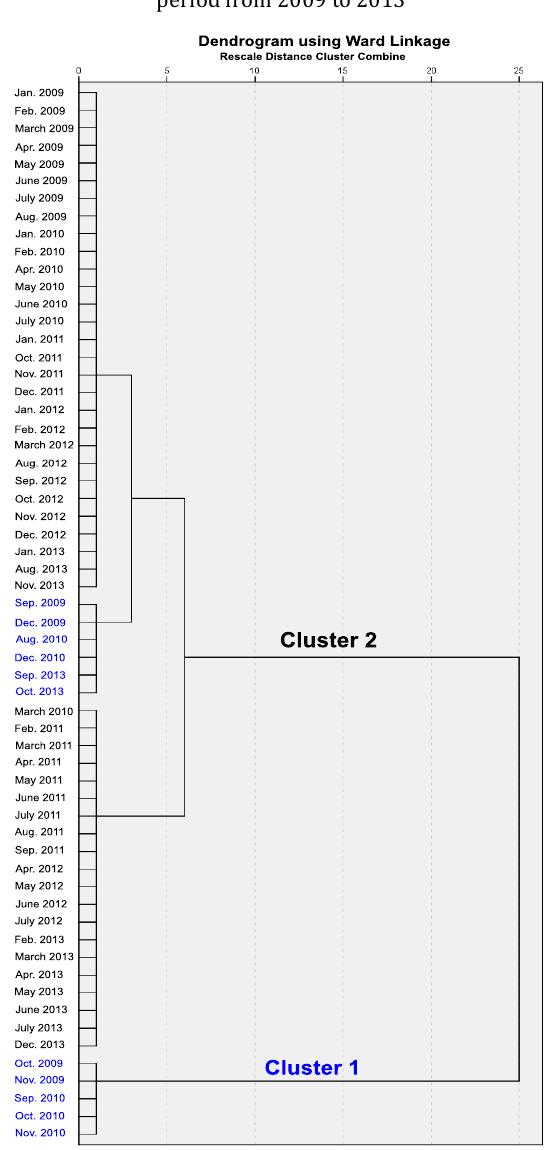
Fig. 6. Dendrogram of cluster analysis for sampling water during the period from 2009 to